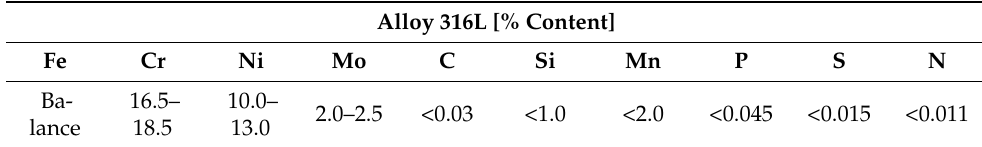
Table 1. Chemical composition of type 316L